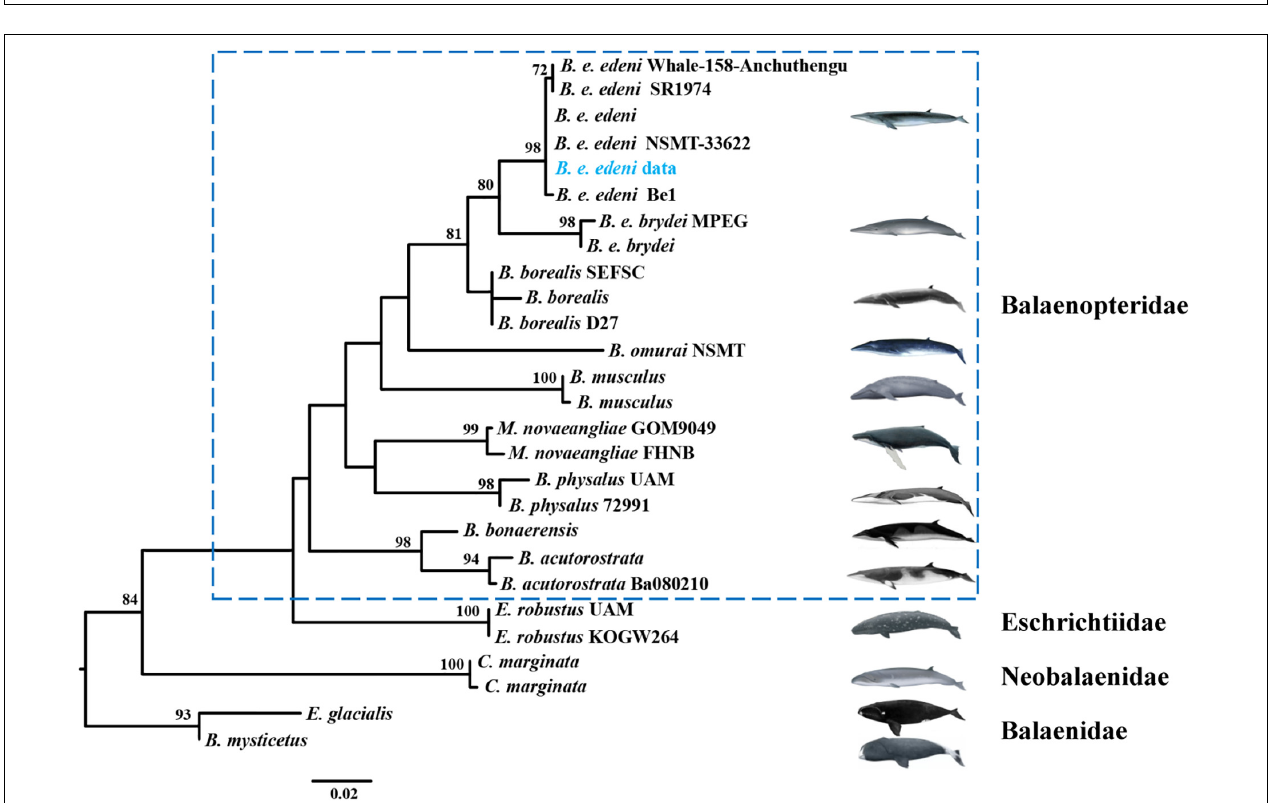
FIGURE 2 | Phylogenetic tree showing the relationship among Mysticeti. Bootstrap support values shown on each node. Data on references sequences provided in Supplementary Table 1 . Bootstrap support values of under 70% are not displayed. Newly obtained sequence from present study highlighted in blue font.